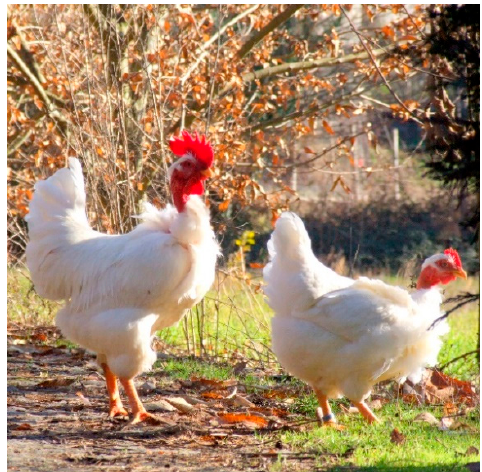
Figure 1. Portuguese autochthonous Branca breed (male and female).